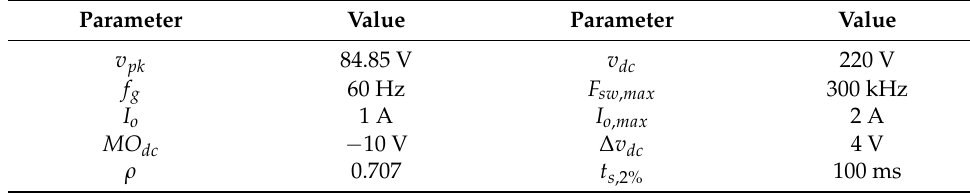
Table 2. Parameters for the application